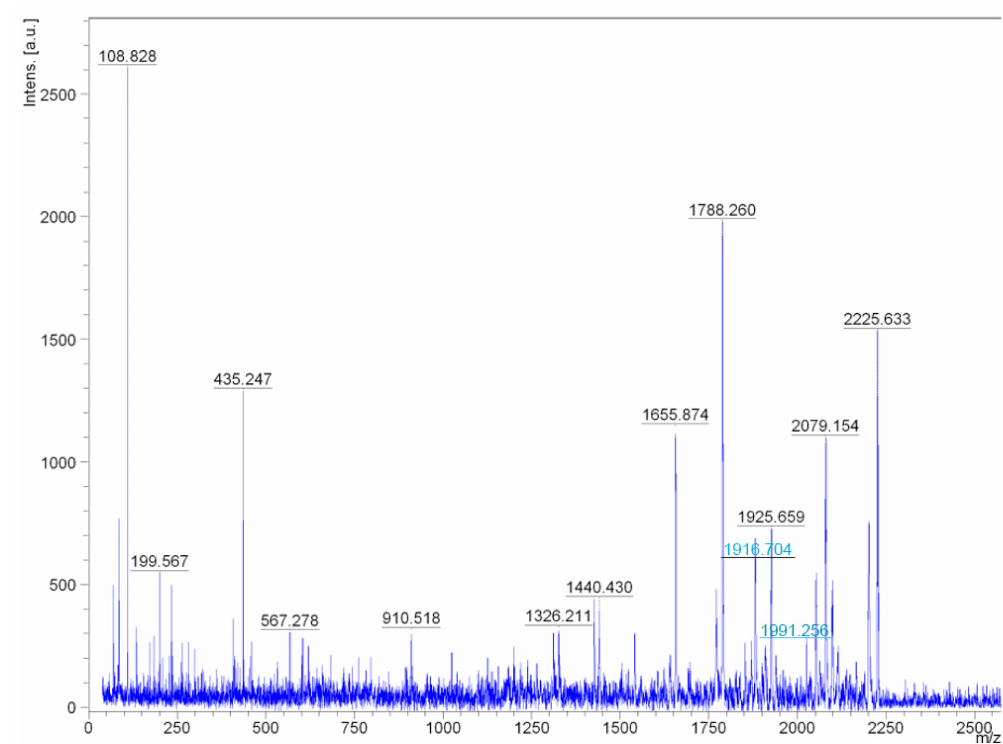
Figure 4. Molecular fragments of peptides of fractions A/1 obtained by the MALDI-TOF/TOF method.